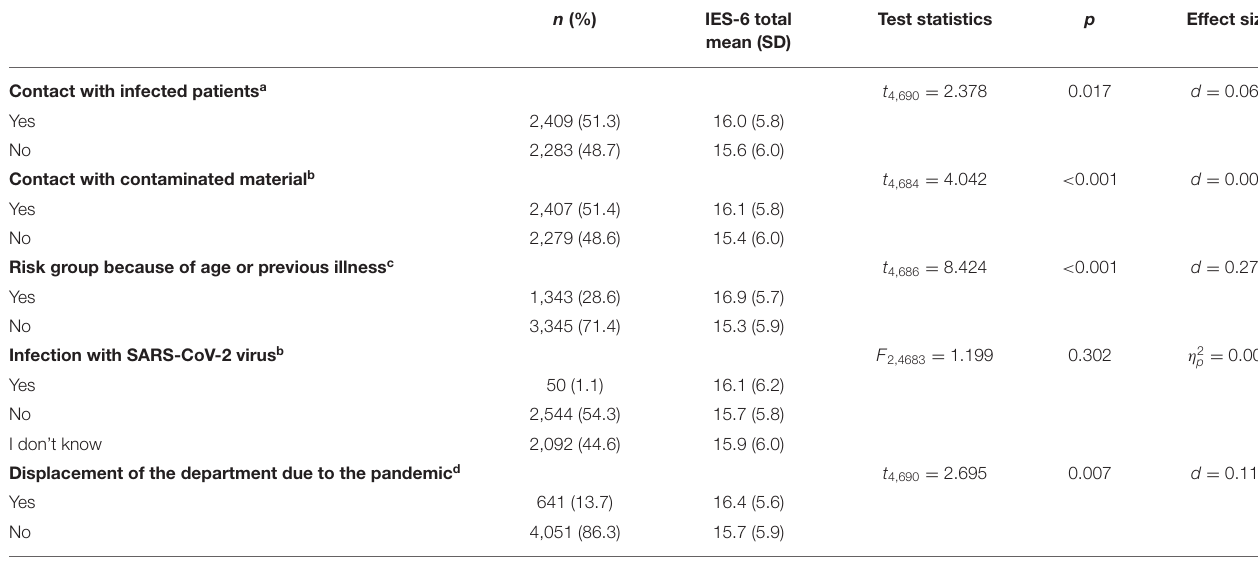
TABLE 2 | Group differences in PTSD symptoms with regards to COVID-19-related characteristics among the sample of healthcare workers ( N = 4,724).